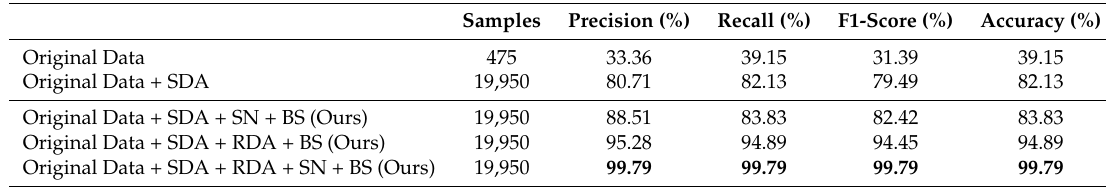
Table 5. Results for the single-object classification task. SDA = standard (RGB) data